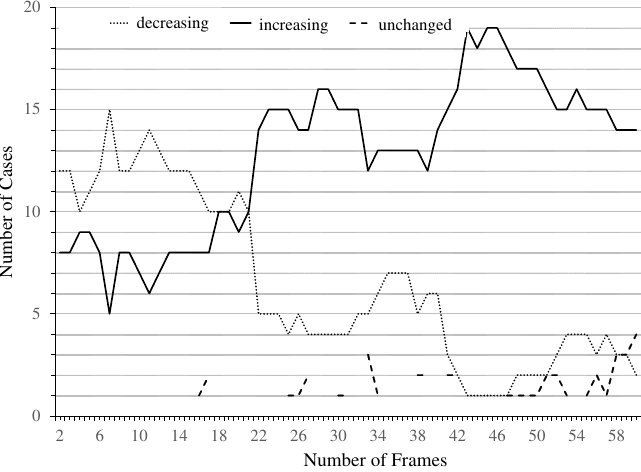
Figure 4. Variation of the power spectrum in the α wave band when ultrasonic sound is